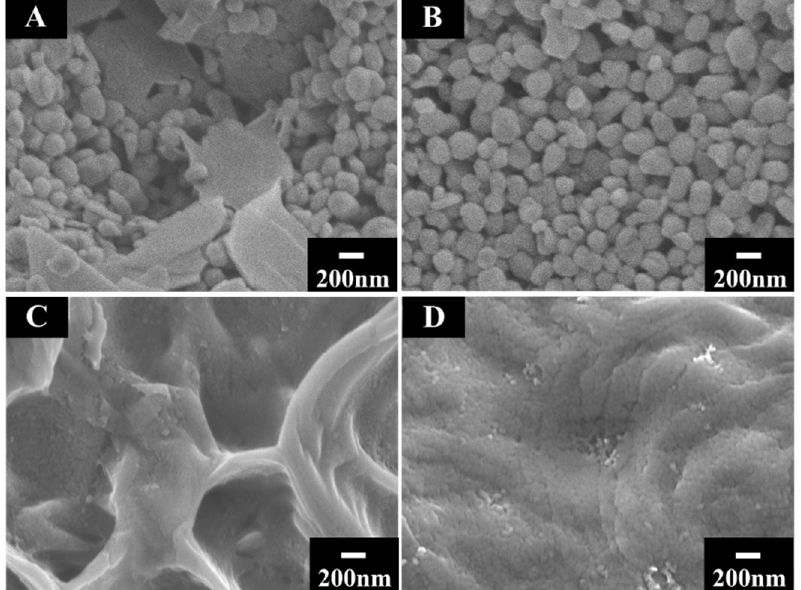
Figure 6. SEM data for films ( A , B ) before and ( C , D ) after annealing (1 h at 350 °C), for films prepared using 1 gL ⁻ 1 CBXNa 2 with ( A , C ) 5 gL ⁻ 1 PTFE and ( B , D ) 10 gL ⁻ 1 PTFE in ethanol-water solvent at 50 V.